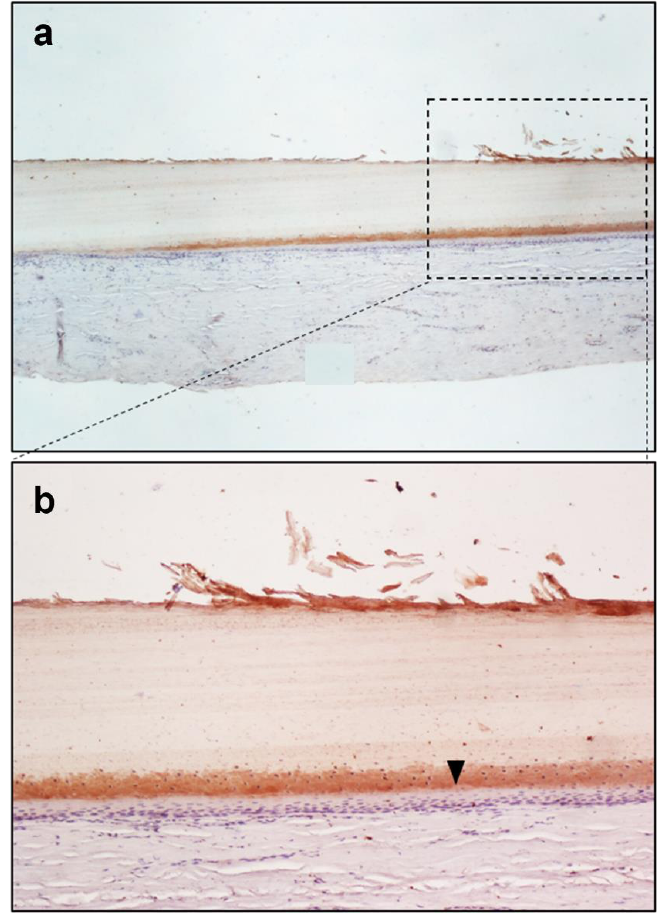
Figure 1. Immunoperoxidase staining for Sheep Anti-Morphine in the fingernail of Subject A. Picture ( a ) shows the 4× magnification, while picture ( b ) shows the 10× magnification. The figure shows the cytoplasmic staining of nail matrix cells of Subject A, indicating morphine positivity, shown in particular by a black arrow on the 10× picture.